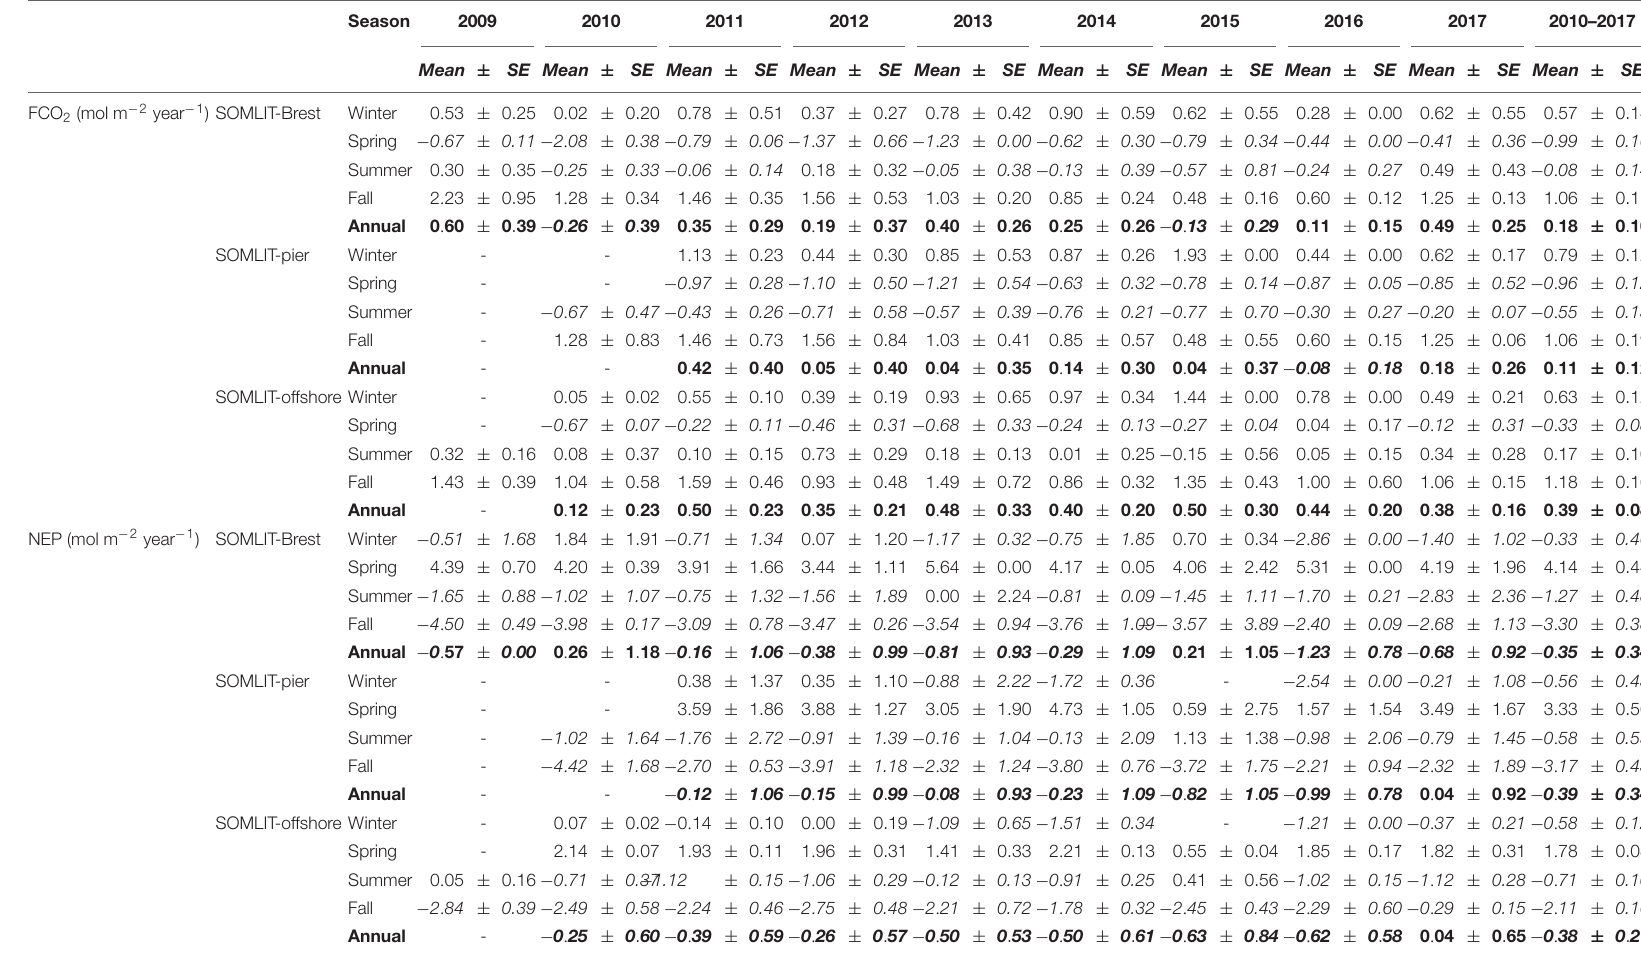
Annual means are represented in bold, negative means are in